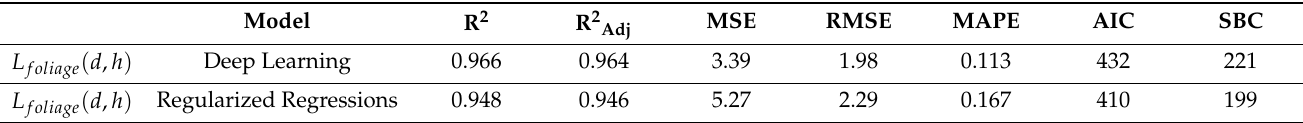
Table 3. Statistical quality assessment comparison between deep learning model and regularized re-